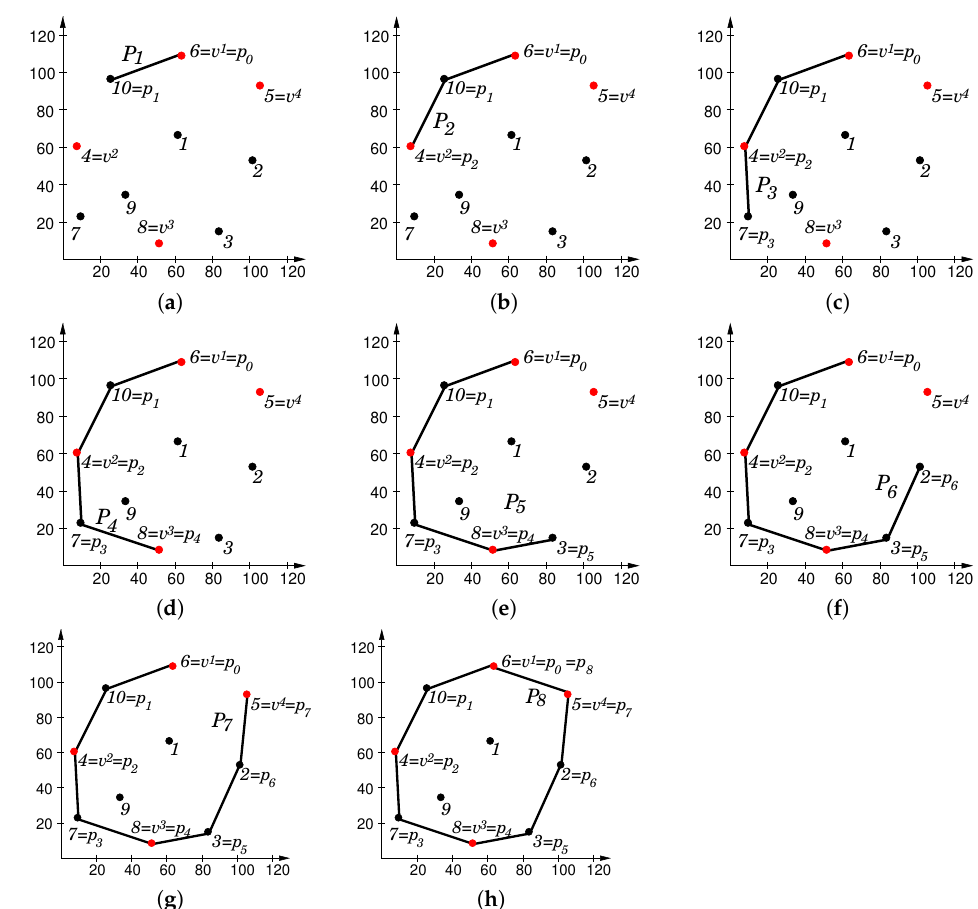
Figure 5. Polygonal lines constructed by algorithm ( GIRDING − POLYGON ) for instance “tsp10”.